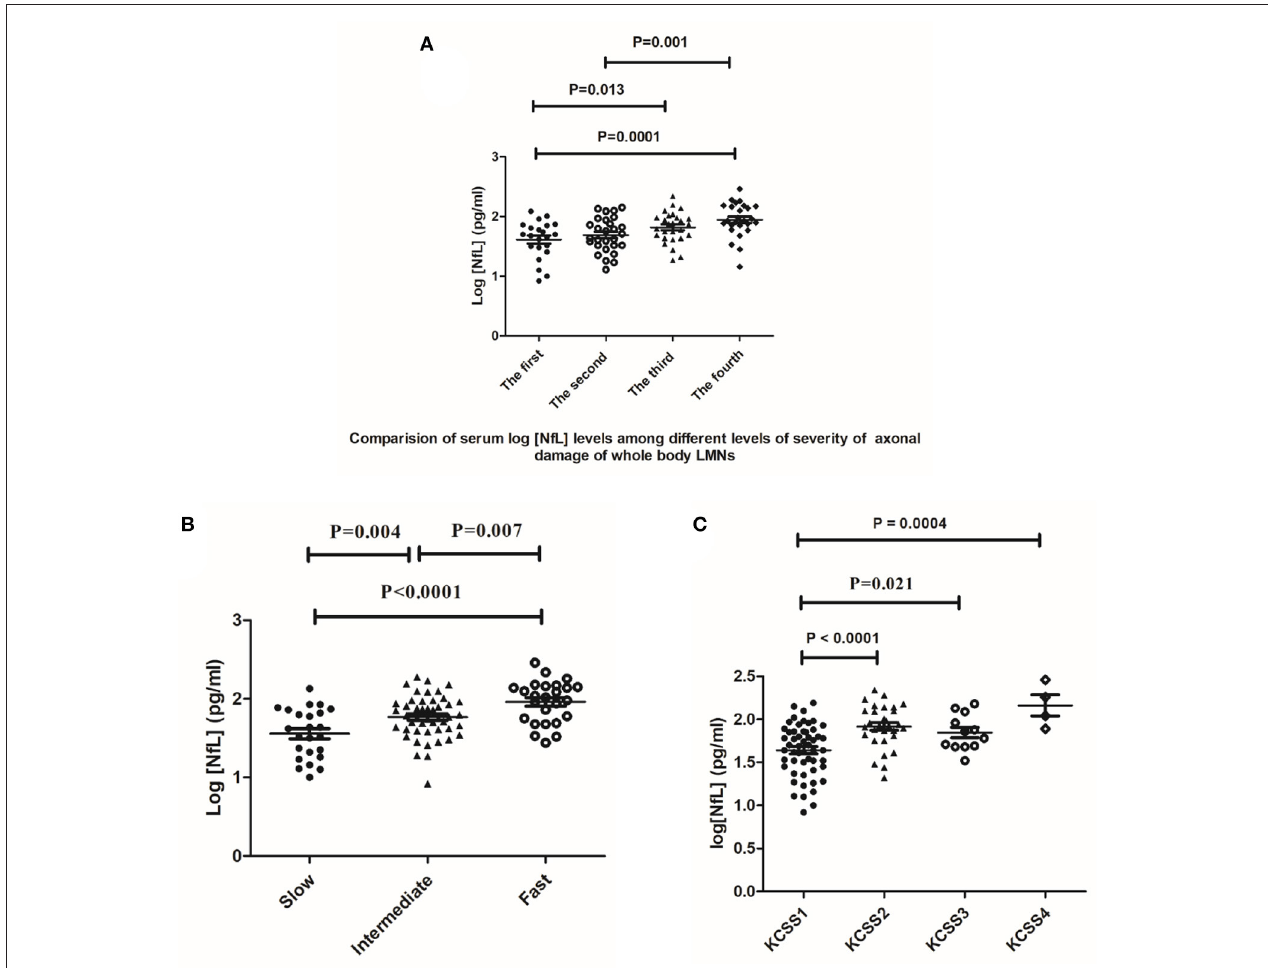
FIGURE 3 | (A) Comparison of serum log[NfL] levels among four relative score quartiles of ALS. The mean value and scatter and dispersion of the observations are shown. Error bars indicate SD. P values were calculated using one-way ANOVA ( N = 103). (B) Comparison of serum log[NfL] levels among the slow progression group, intermediate progression group, and fast progression group ( N = 96). (C) . The serum levels of log[NfL] were positively correlated with the number of regions assessed by KCSS stages ( N = 99). One-way ANOVA with post-hoc analysis by Tukey’s multiple comparison